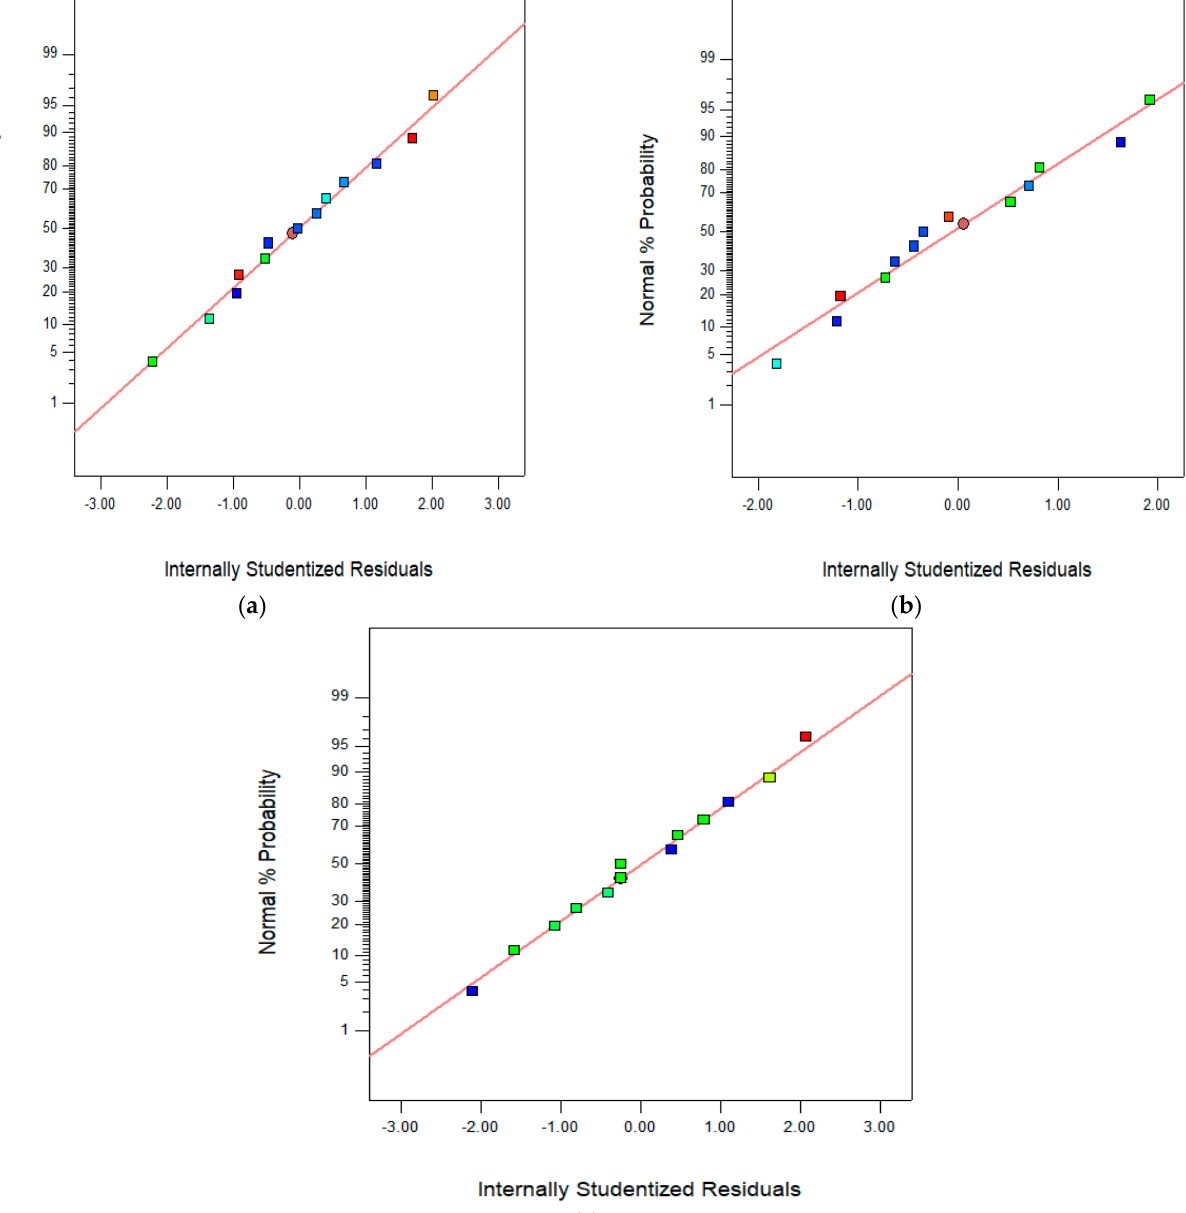
Figure 3. Normal plots against internally studentized residuals for durability models. ( a ) Weight Loss (H 2 SO 4 ), ( b ) Weight Loss (MgSO 4 ), and ( c ) Water Absorption.